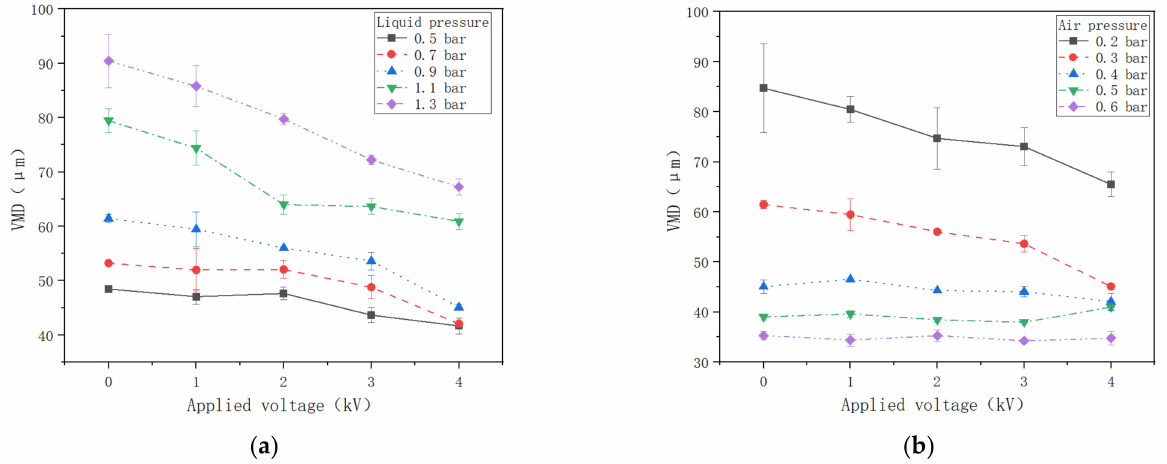
Figure 7. VMD variation with the applied voltage. ( a ) Air pressure of 0.3 bar, ( b ) Liquid pressure of 0.9